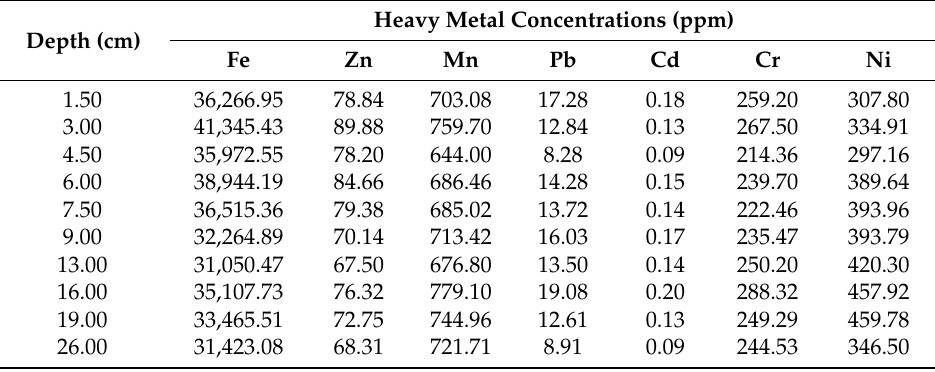
Table 5. The heavy metal concentrations in vertical profile of core samples. Heavy Metal Concentrations (ppm) Depth (cm)